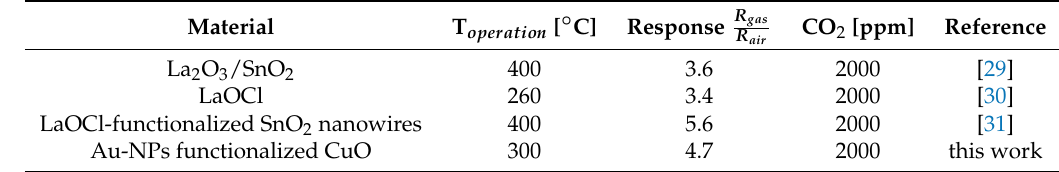
Table A1. CO 2 responses of various metal oxide materials reported in